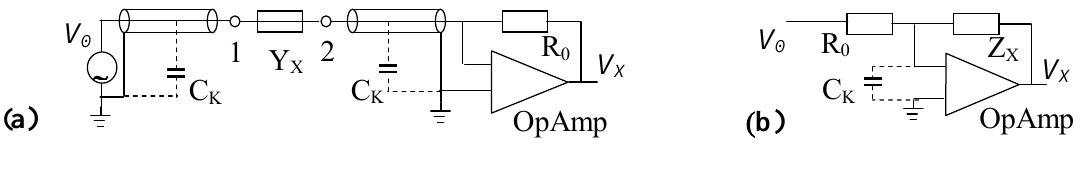
Figure 2. Electric circuit of normal active converters: (a) for complex conductance and (b) for complex resistance